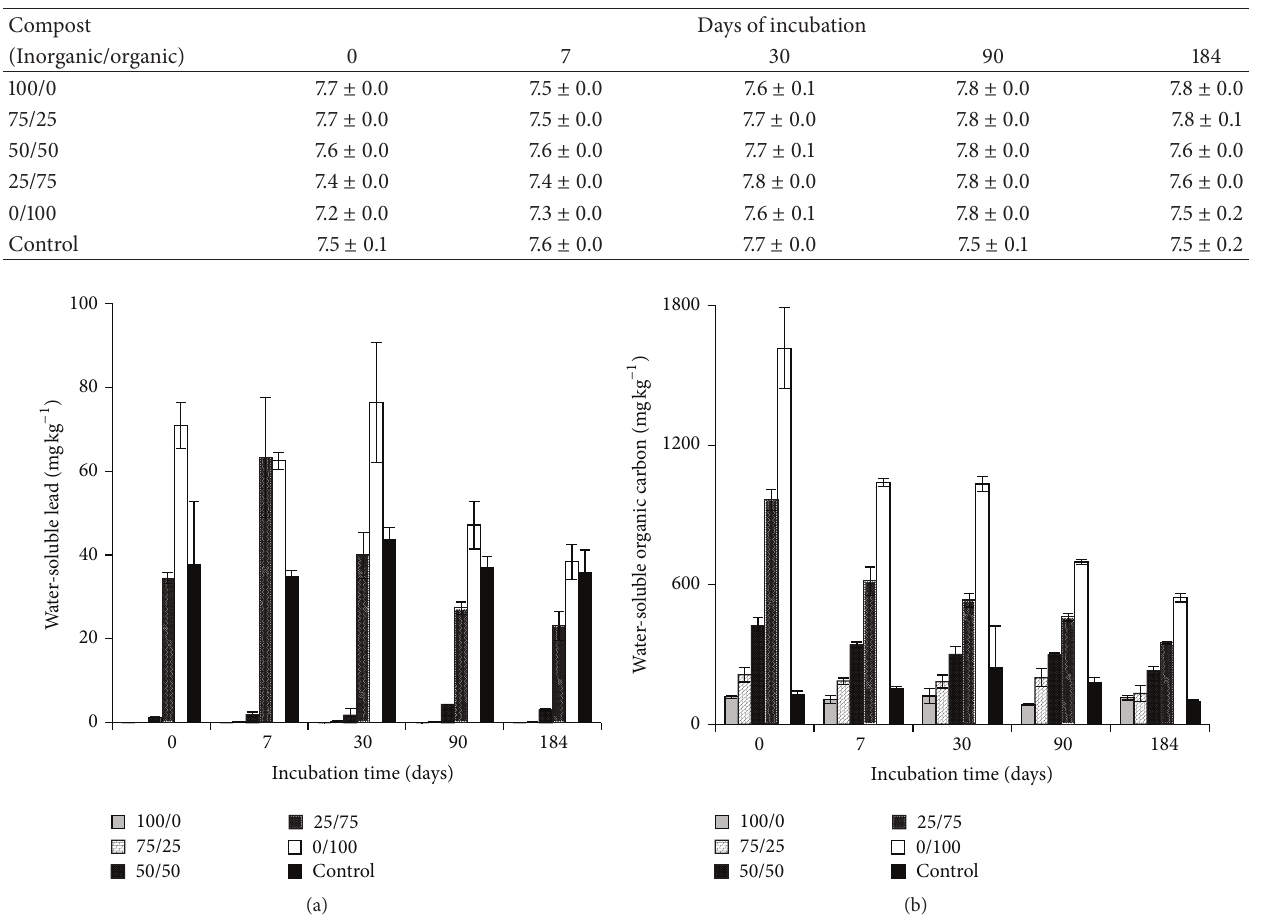
Table 3: pH in soils amended with simulated compost during incubation period ( 𝑛 = 3 ).